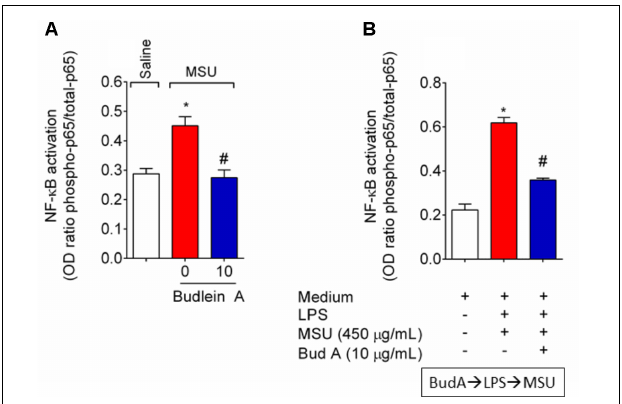
FIGURE 7 | Budlein A reduces MSU-induced NF- κ B activation. Fifteen hours after the injection of MSU crystals, knee joint was dissected for the determination of NF- κ B activation in vivo by ELISA (A) . In vitro , BMDMs were pre-treated with budlein A at 10 µ g/mL 30 min before stimulus with LPS for the determination of NF- κ B activation by ELISA (B) . BMDMs cell lysates were collected 5 h after MSU (B) . ∗ p < 0.05 vs. saline group; # p < 0.05 vs. 0 mg/kg group, one-way ANOVA followed by Tukey’s post hoc .